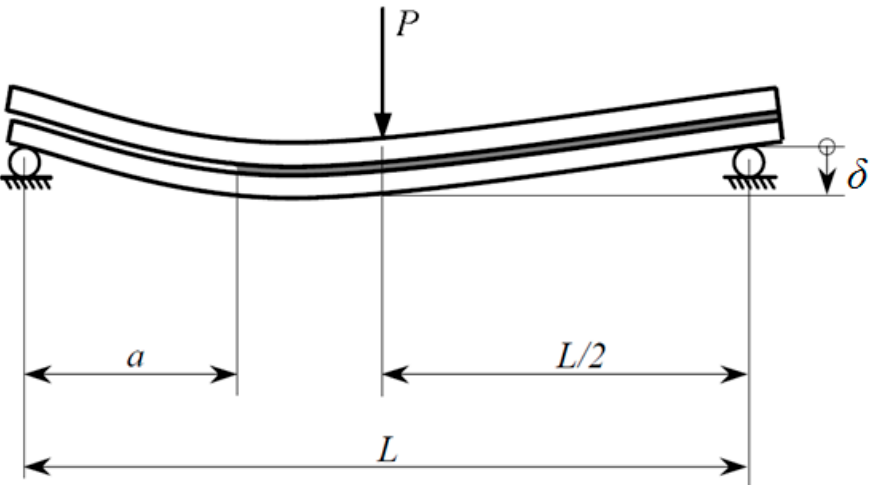
Figure 4. Schematic representation of the double cantilever beam (DCB) test. P is the imposed load, δ is the crack opening displacement, and a is the crack length.